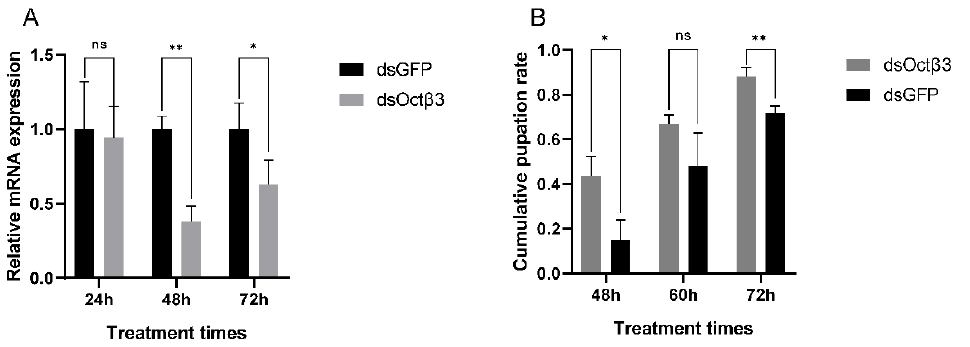
Figure 5. Effect of silencing PxOct β 3 expression on pupation in Plutella xylostella. ( A ) The relative levels of mRNA expression of PxOct β 3 after injection with 200 ng dsOA2B3 and dsGFP. DsRNAs were injected into one − day − old fourth − instar larvae. The relative levels of mRNA expression of PxOct β 3 were determined using RT − qPCR at 24 h, 48 h, and 72 h postinjection. ( B ) The pupation rate of P. xylostella larvae at 48 h, 60 h, and 72 h postinjection. Error bars represent the standard error of the calculated means based on three biological replicates. Asterisks indicate significant differences (Student’s t − test, p < 0.05). dsGFP, double − stranded green fluorescence protein; dsRNA, double − stranded RNA; RT − qPCR, quantitative reverse transcription PCR. *** p ≤ 0.001, ** p ≤ 0.01, * p ≤ 0.05, ns means no significant.